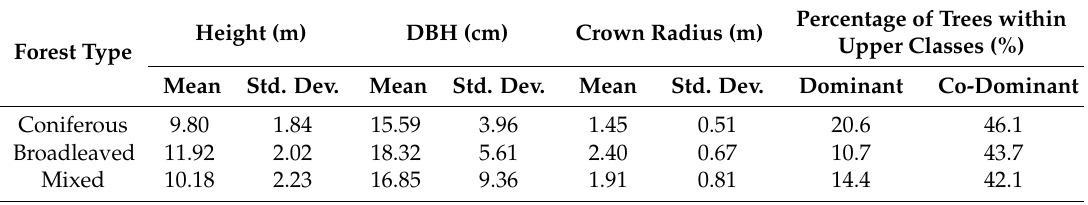
Table 1. Description of the forest characteristics of three forest types.